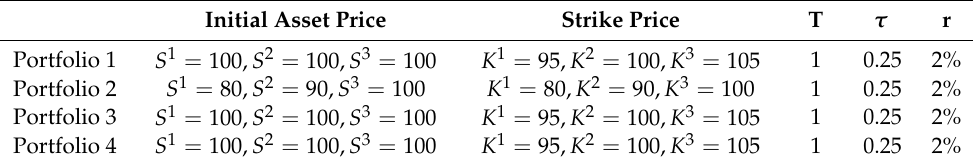
Table 1. The parameters setting for underlying assets following the Lévy process.